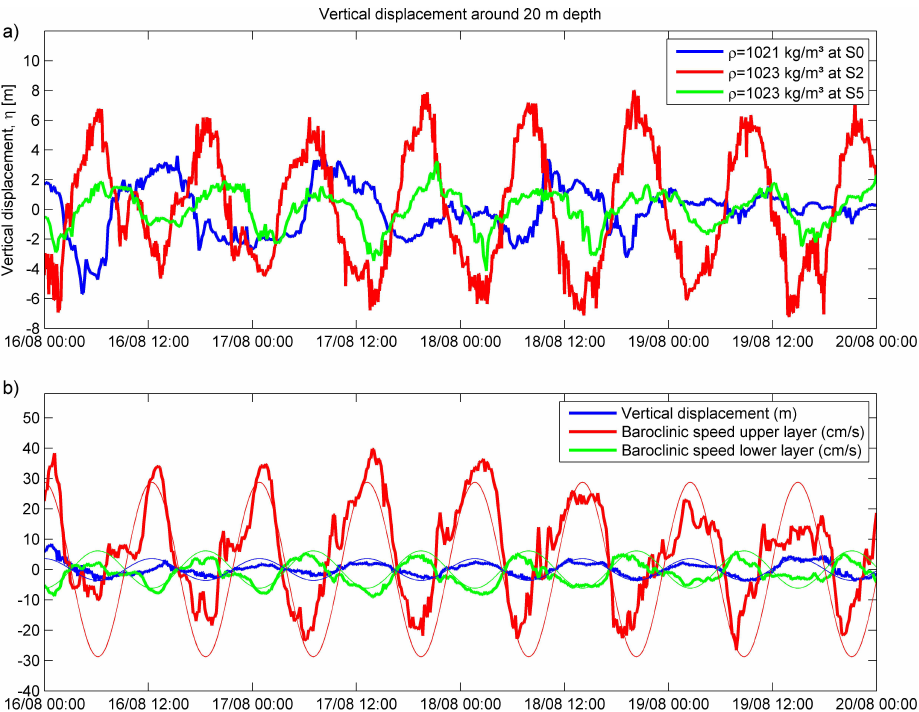
Fig. 6. (a) Vertical displacement of density surfaces at station S0, S2 and S5 at 20m depth. (b) Vertical displacement and baroclinic speed in the upper and lower layer at station S2. Bold lines are the results from measurements, and thin lines are results from a two-layer